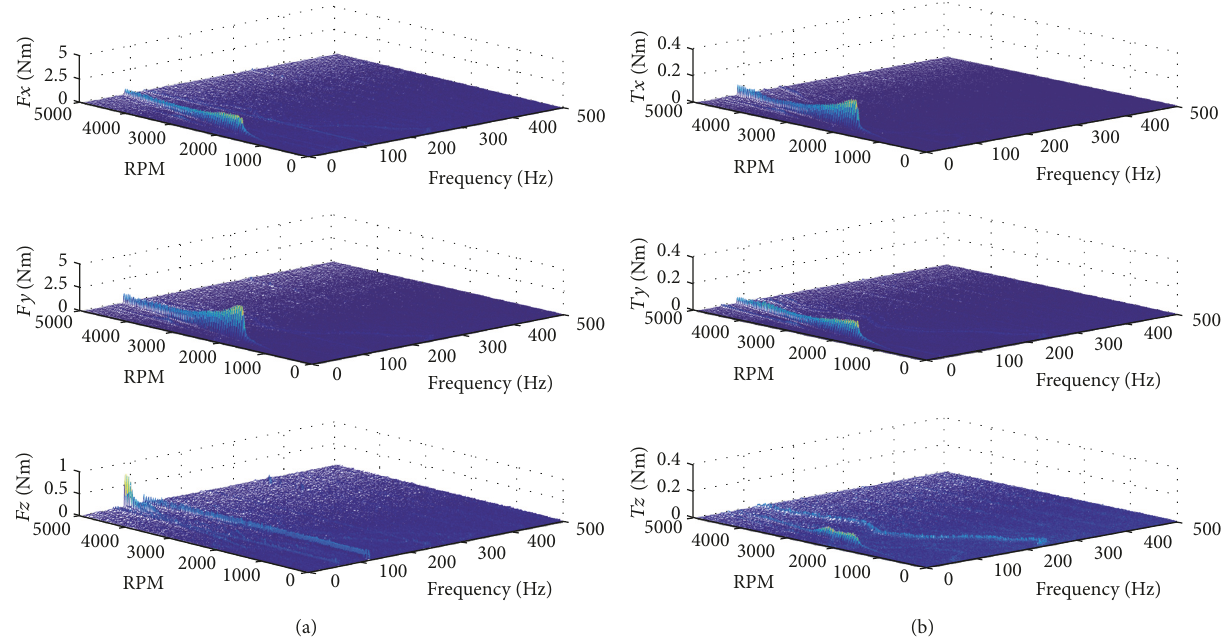
Figure 16: Waterfall plots of disturbance forces and torques for RWA activation with isolation ((a): disturbance forces and (b): disturbance